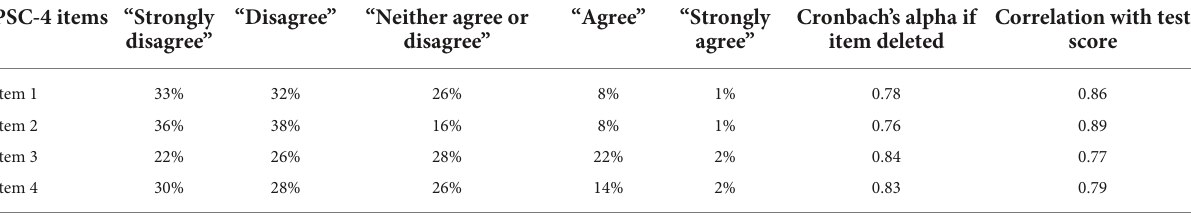
TABLE 1 Distribution of PSC-4 items responses in percentage, Cronbach’s alpha if the item was deleted, and correlations with test score.